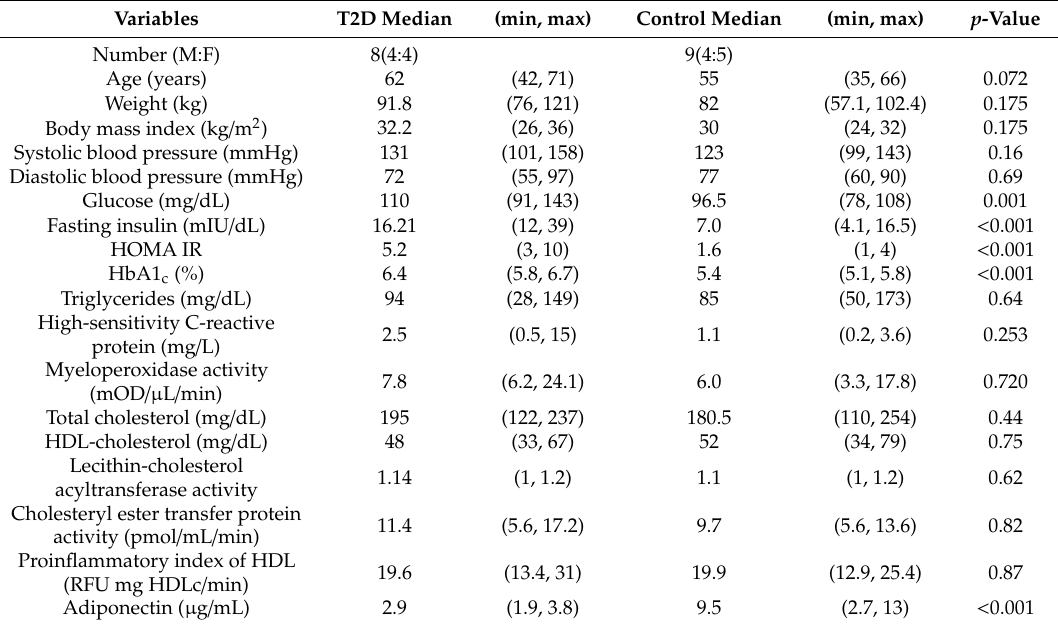
Table 1. Demographic and biochemical characteristics of study